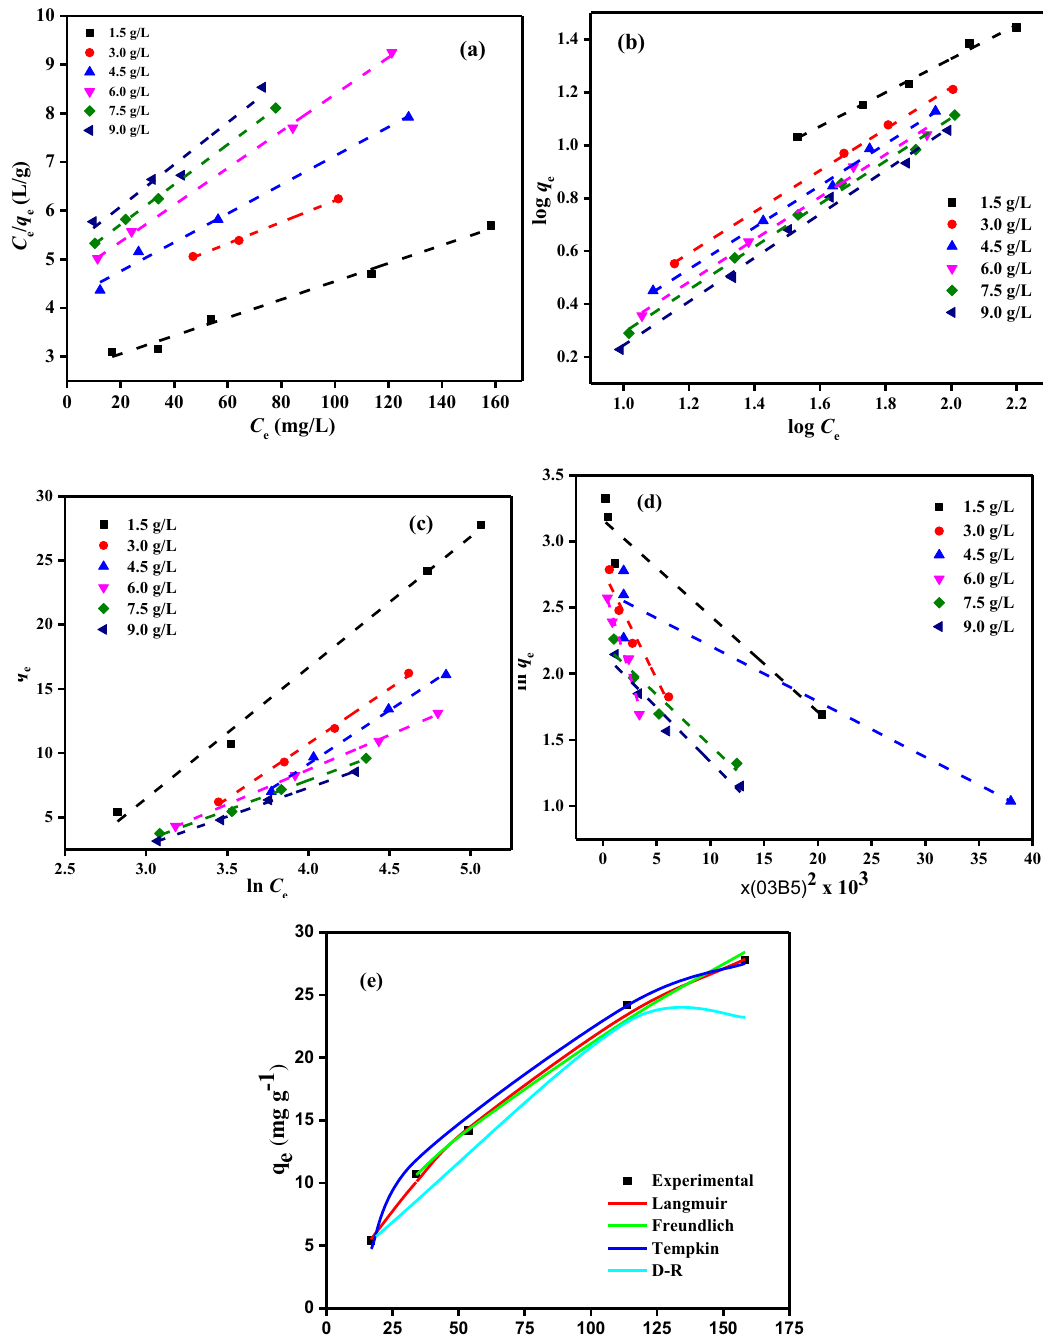
Figure 11. ( a ) LIM ( b ) FIM ( c ) TIM ( d ) DRIM profiles for DB86 dye of C 0 (25–200 mg/L) on CAH (1.5– 9.0 g/L) at (25 ± 2 °C) ( e ) Differentiation between the experimental results and estimated from IM for DB86 dye of C 0 (25–200 mg/L) on CAH (1.5 g/L) at (25 ± 2